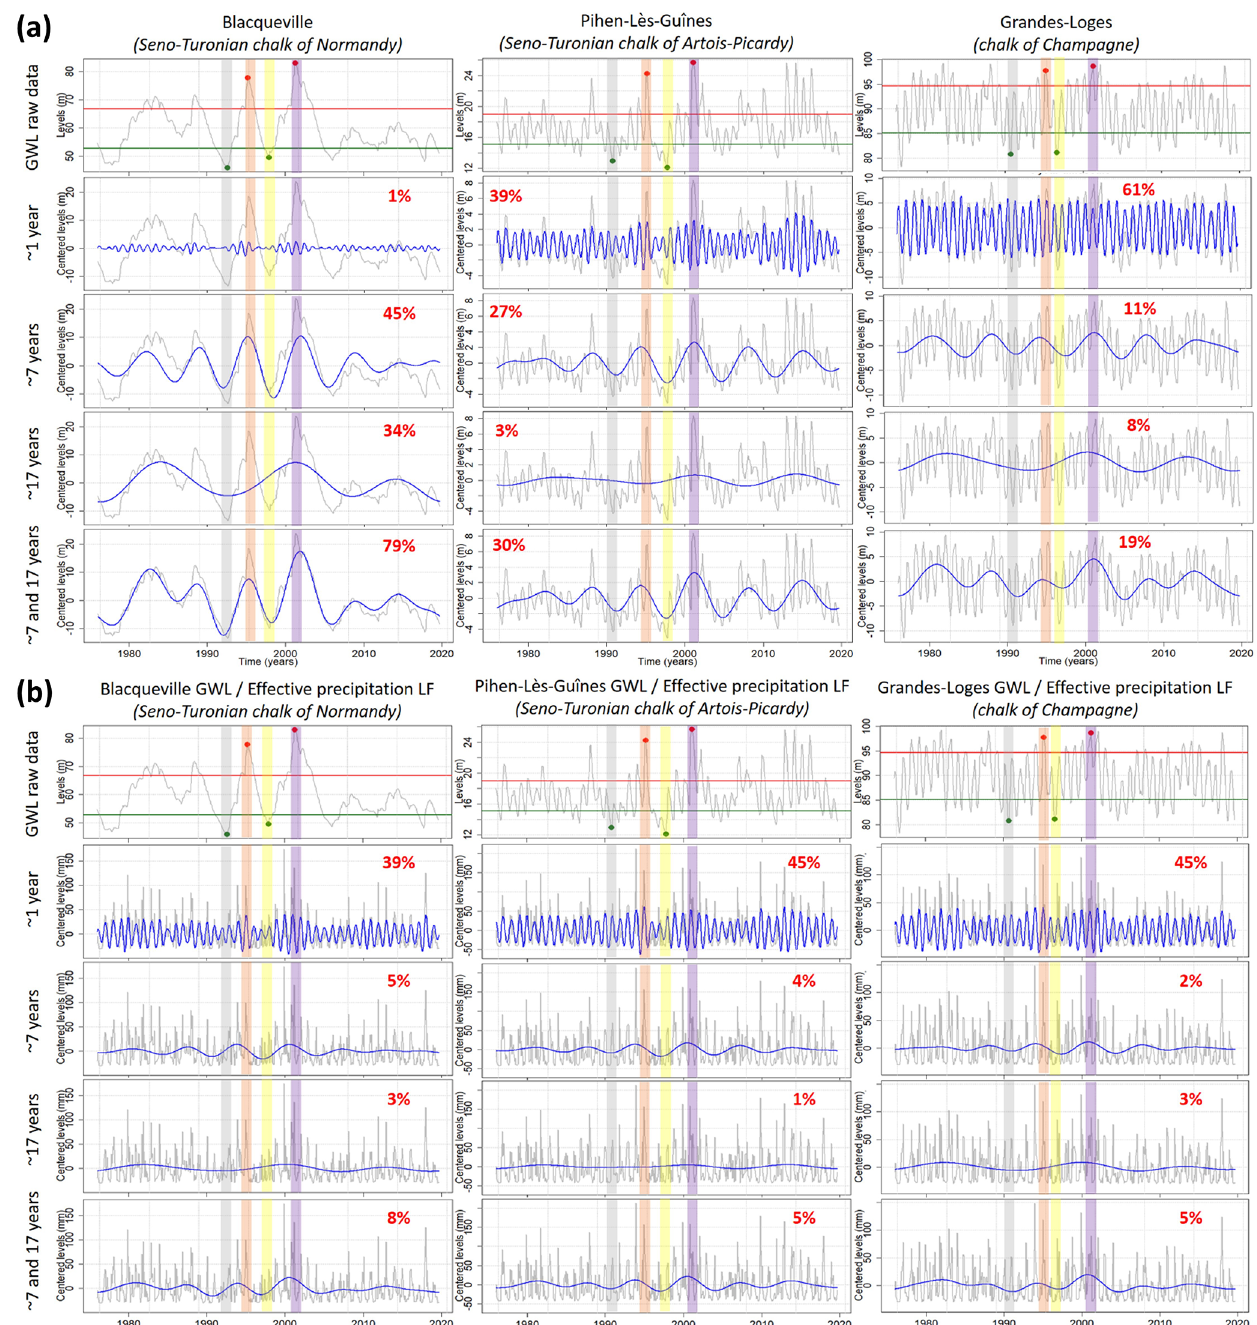
Figure 14. Extraction of ∼ 1-year (AV), ∼ 7-year (MAV), and ∼ 17-year (DV) components in (a) groundwater levels of three boreholes monitoring chalk aquifers and in (b) effective precipitation corresponding to the three boreholes. The 1992 low level is highlighted in gray, the 1995 high level in orange, the 1998 low level in yellow, and the 2001 high level in purple. The energy percentage of each component or association of components is indicated in